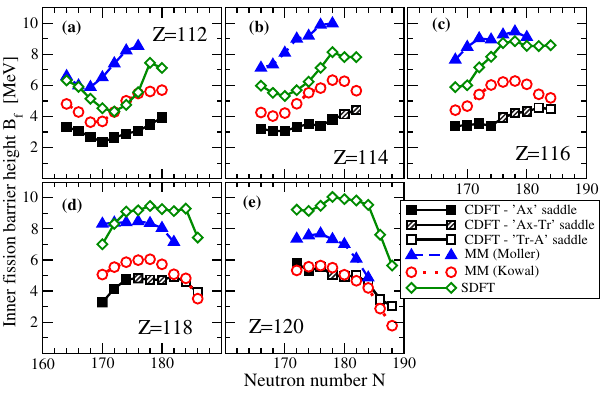
Figure 4. Inner fission barrier heights B f as a function of neutron number N . The results of the MM calculations are taken from Ref. [14] (labeled as “MM (Möller)”) and Ref. [17] (labeled as “MM (Kowal)”). The results of the Skyrme DFT calculations with the SkM* parametrization (labelled as “SDFT”) are taken from Ref. [26].